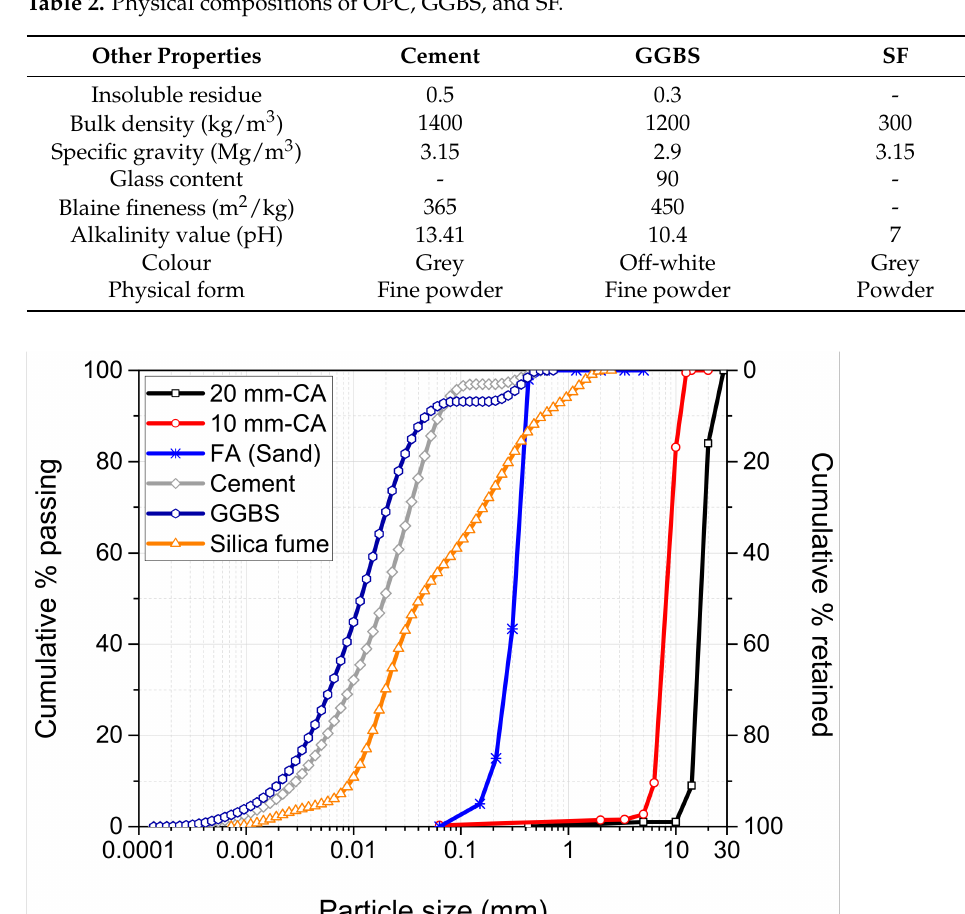
Figure 1. Particle size distribution of the raw materials.